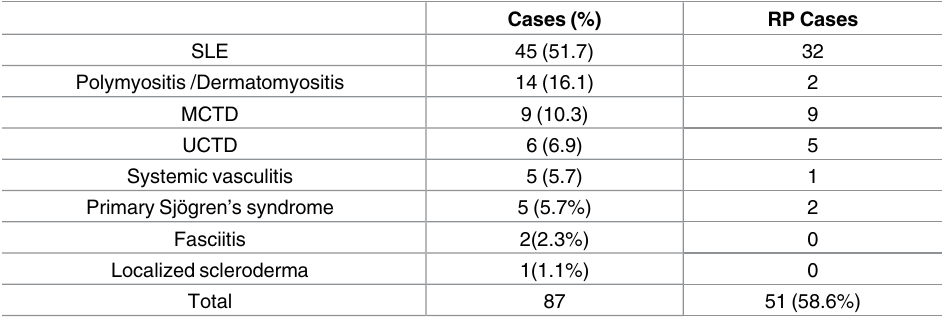
Table 1. Diseasespectrum of other connective tissue diseasesused as controls.